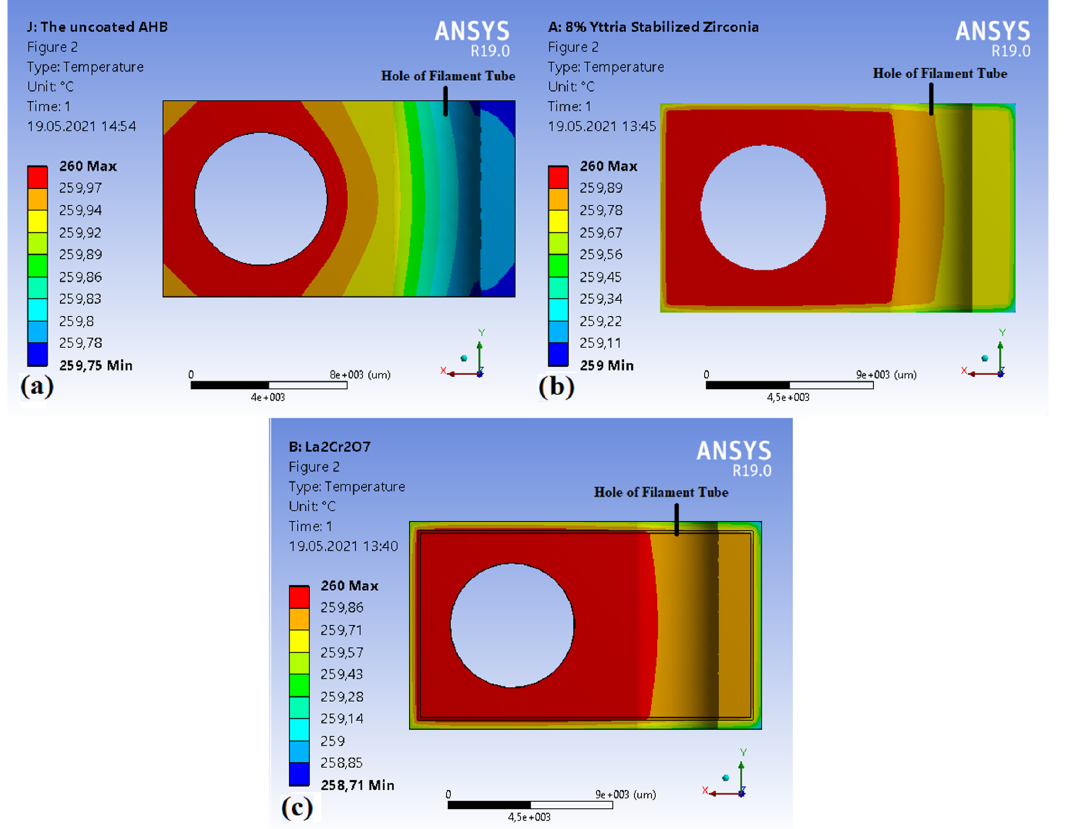
Figure 8. Cross-sectional view of the temperature distribution of ( a ) uncoated, ( b ) YSZ-coated, and ( c ) La 2 Cr 2 O 7 -coated AHB.